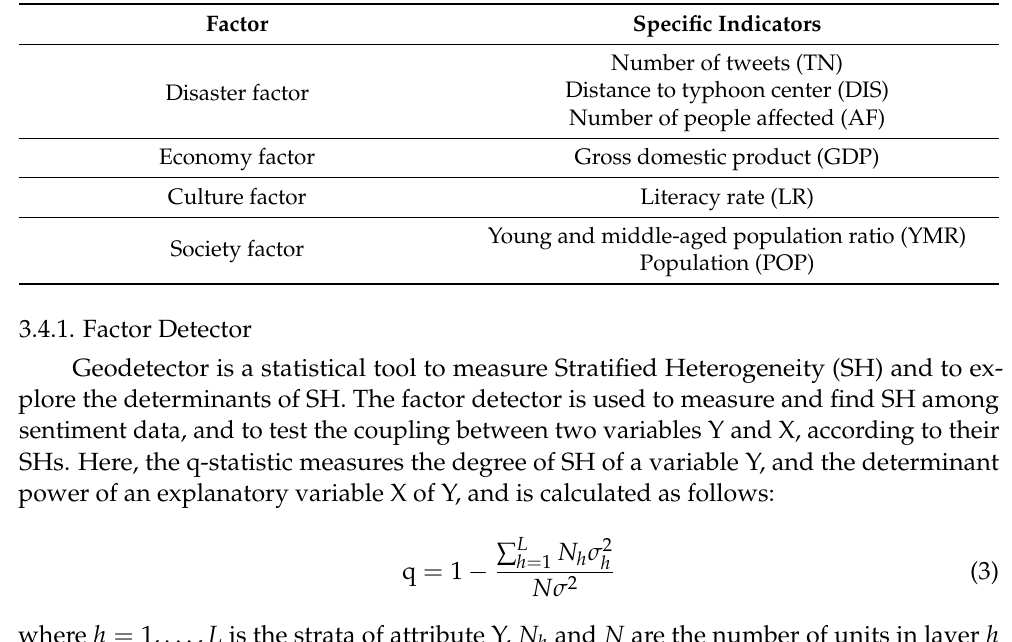
Table 2. Seven specific indicators of four